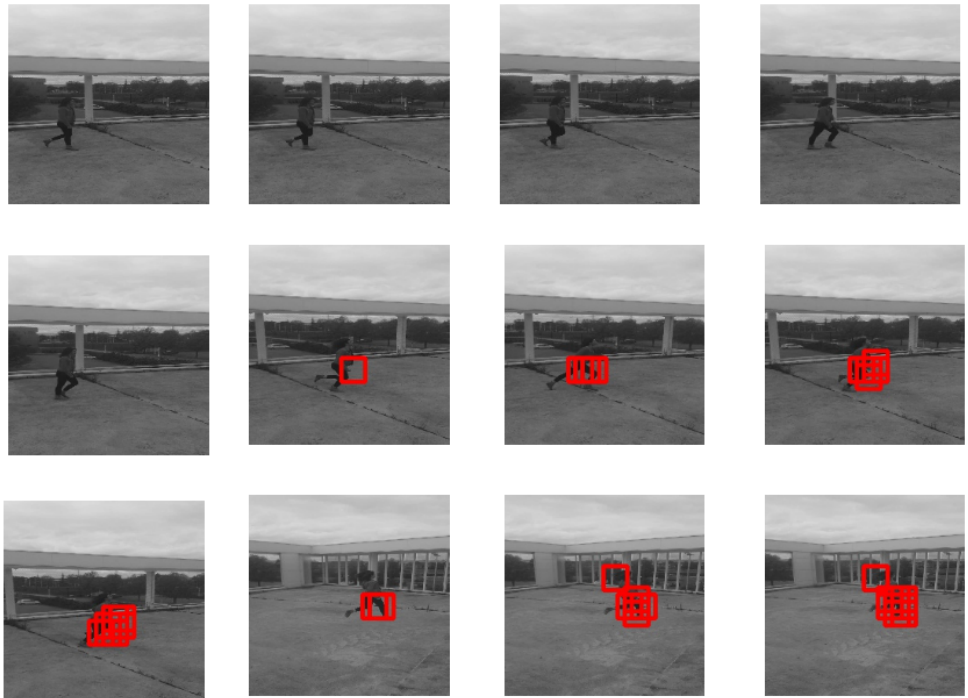
Figure 8. Our results on the brutal running